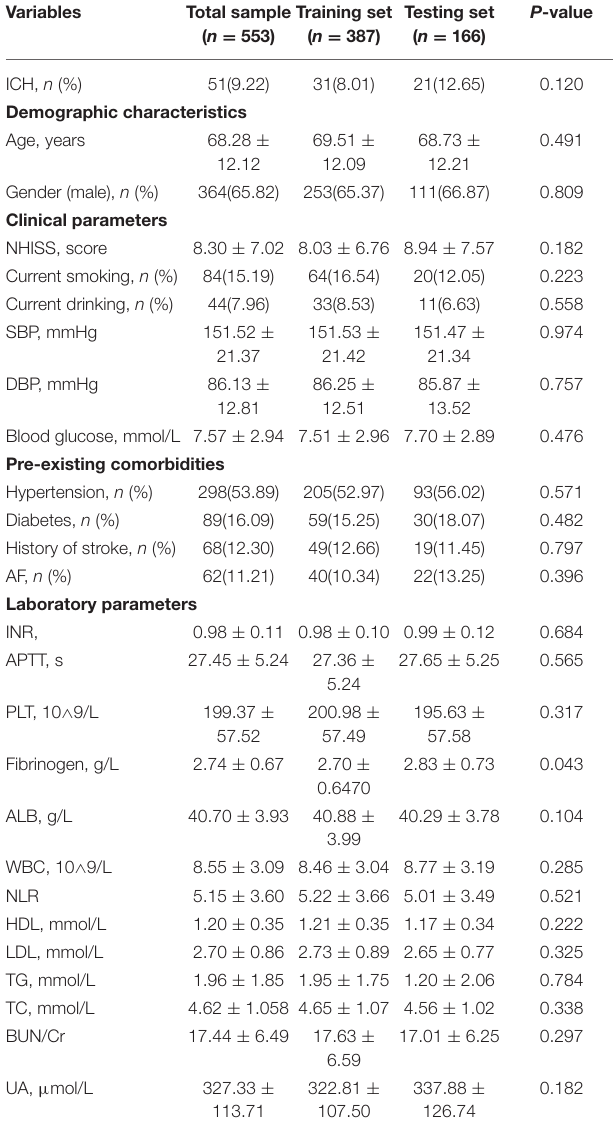
TABLE 1 | Baseline characteristics of AIS patients with IVT in the training and testing sets.